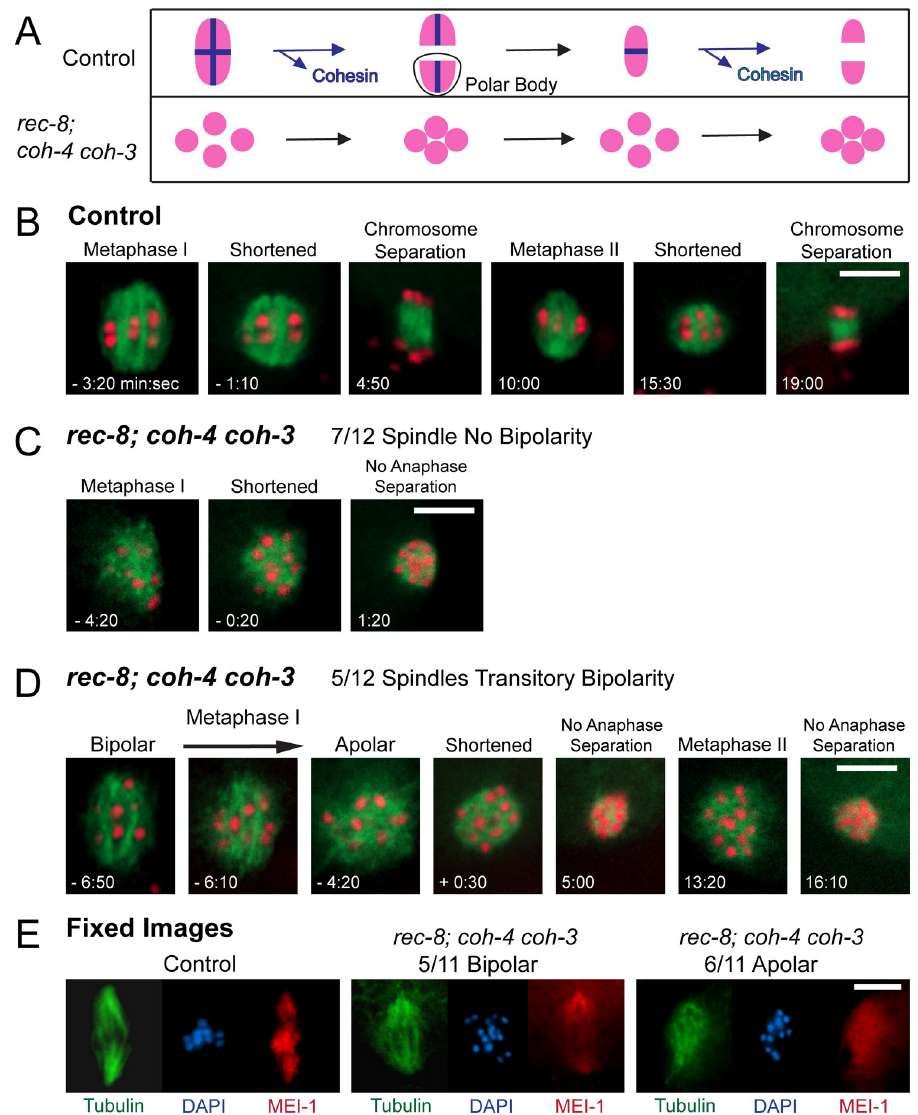
Fig 2. Bipolar spindles can form in rec-8; coh-4 coh-3 embryos, but they are unstable and become apolar. (A) In metaphase I of control embryos, both sister chromatids and homologs are bound by cohesin; homologs are released and separate in Anaphase I; sister chromatids are released and separate in anaphase II. In rec-8; coh-4 coh-3 embryos, no cohesin is present in either MI or MII and chromatids do not separate. (B) Time-lapse images of a control embryo expressing mNG::TBB-2 and mCH::HIS-11 show bipolar meiosis I and meiosis II spindles which shorten and undergo anaphase chromosome separation. Time 0:00 for B, C, and D is the time of full contact between the spindle and the cortex. (C) Time-lapse images captured with 7/12 rec-8; coh-4 coh-3 embryos expressing mNG::TBB-2 and mCH::HIS- 11 show MI spindles which were apolar at ovulation, then shortened and chromosome separation did not occur. MII (not shown) was similar to MI. (D) In 5/12 embryos, MI spindles initially appeared to be bipolar, but were unstable and became apolar. The MI spindles shortened and no anaphase chromosome separation occurred. MII was similar to MI. (E) Control and rec-8; coh-4 coh-3 embryos were fixed and stained with both tubulin and MEI-1 antibodies and with DAPI. 10/10 Control and 5/11 mutant embryos had spindles with MEI-1 concentrated on chromosomes and at two poles. 6/11 mutant spindles were apolar. All bars = 5 μ